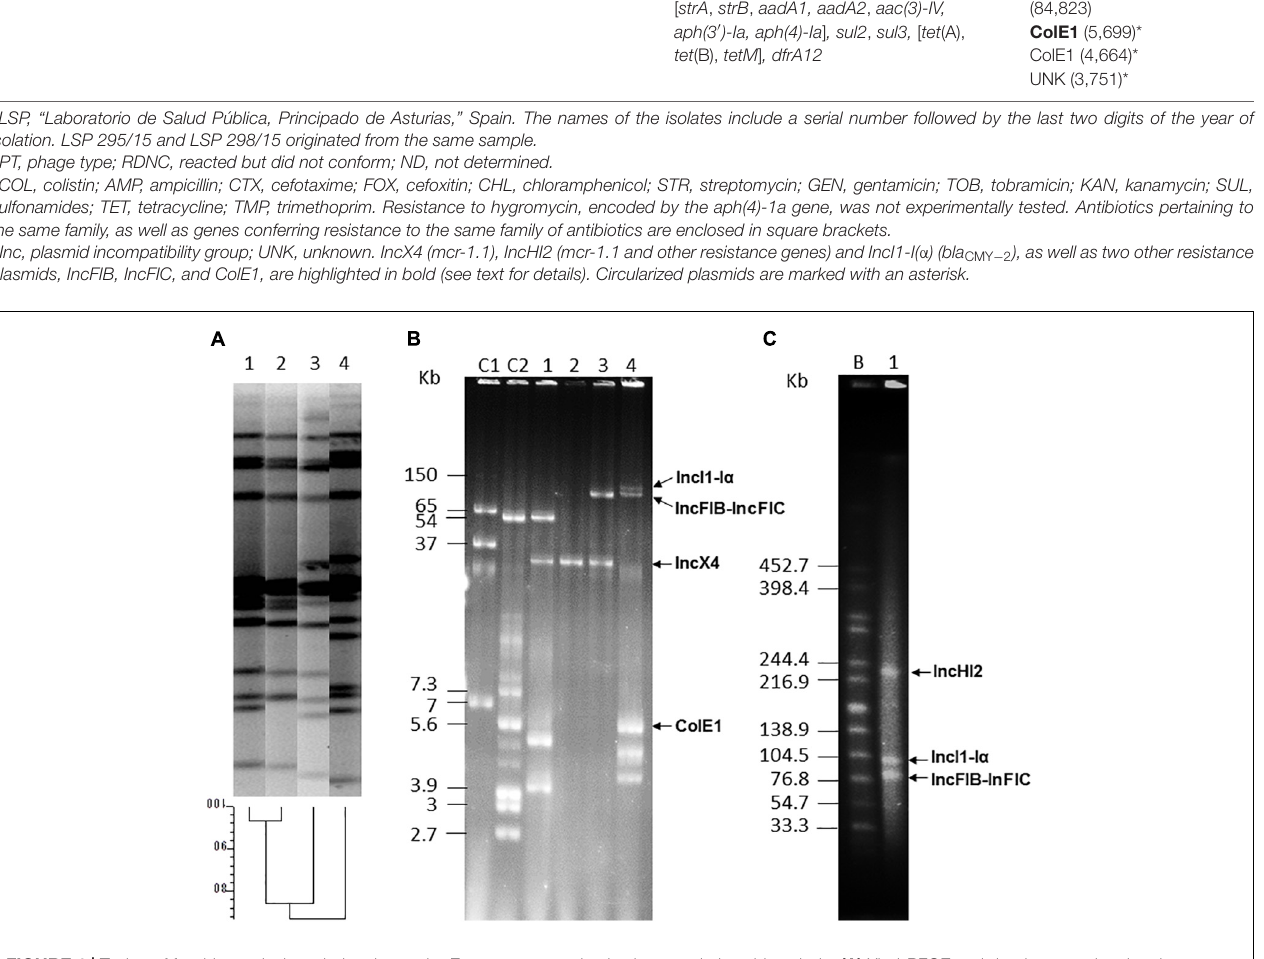
isolates is shown in Figure 2A . As previously reported for other IncX4 plasmids, mcr-1.1 was found adjacent to a putative orf , designated pap2 since it encodes a transmembrane protein